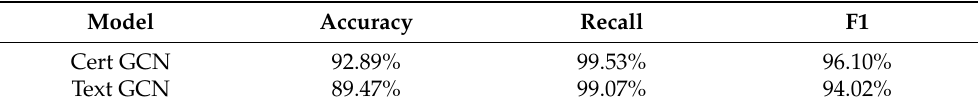
Table 4. Evaluation of model results of benign certificate detection by Cert GCN and Text GCN.